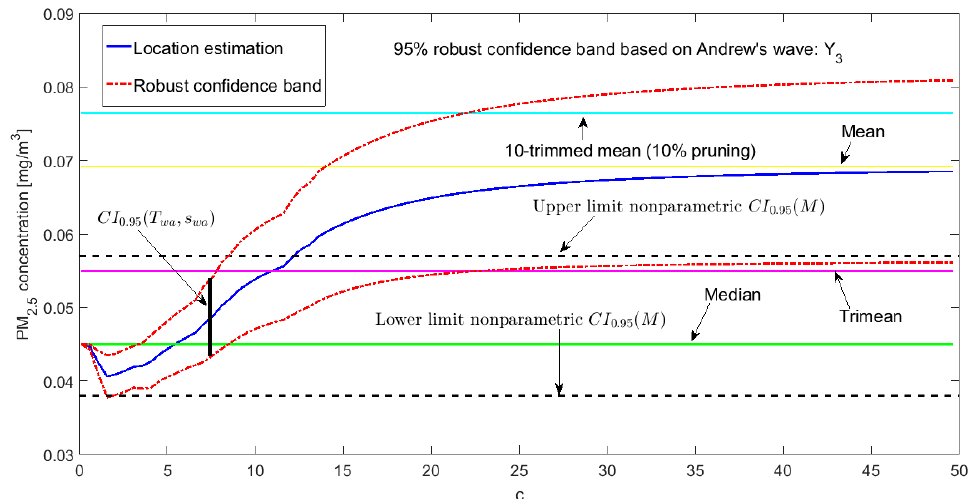
Figure 15. 95% robust confidence band based on the Andrew’s wave: Y 3 .